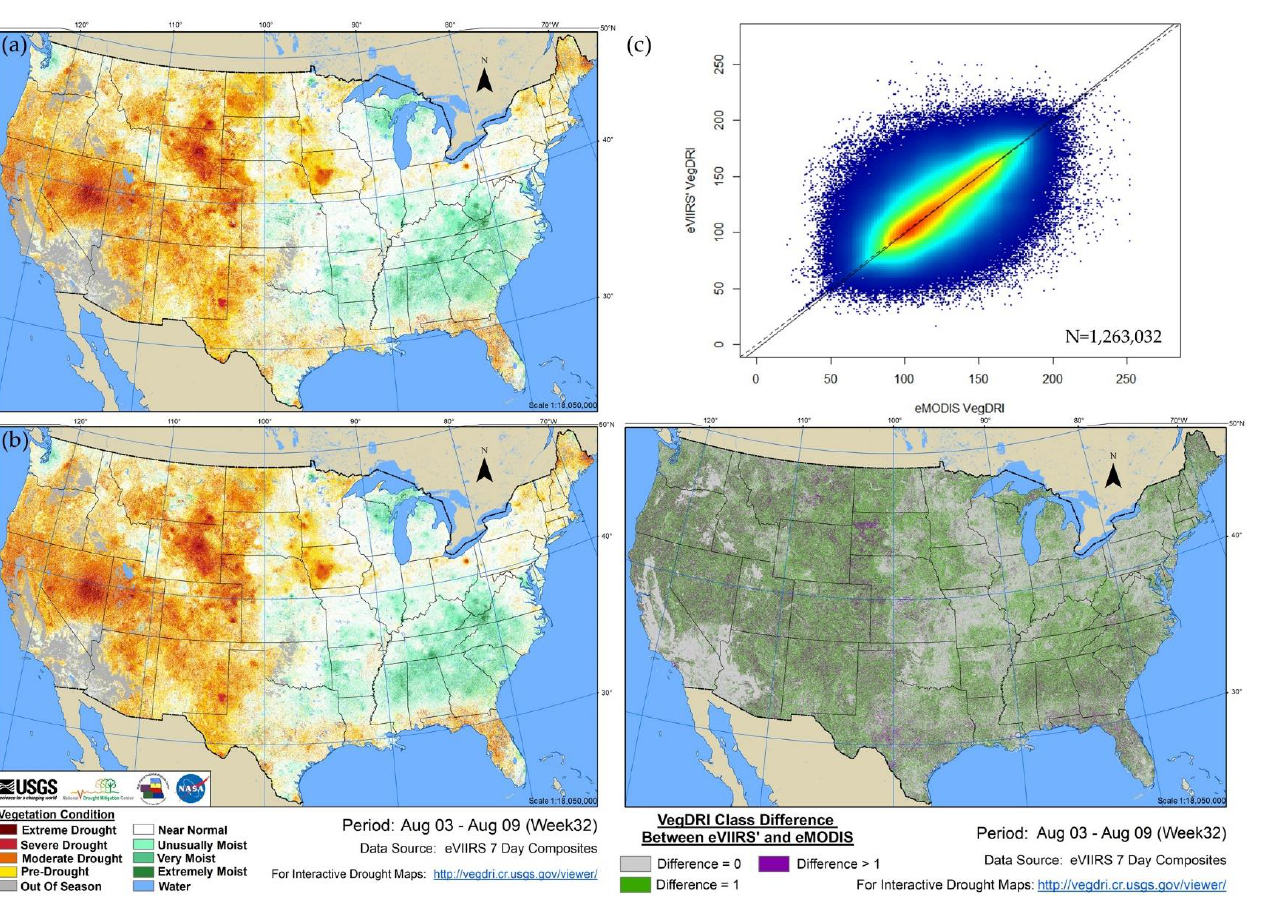
Figure 5. Comparison of Vegetation Drought Response Index (VegDRI) results from expedited Moderate Resolution Imaging Spectroradiometer (eMODIS) ( a ) and transformed expedited Visible Infrared Imaging Radiometer Suite (eVIIRS’) ( b ) for week 32, 2020 (August 3, 2020 to August 9, 2020). ( c ) Relation between eMODIS and eVIIRS’ VegDRI values, associated statistics are presented in Table 2, week 32 column. Point density increases from low (blue) to moderate (green) to high (red), the geometric mean regression (solid line) and the 1-to-1 line (dashed line). ( d ) VegDRI classification differences pixel by